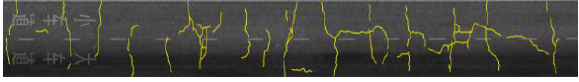
Figure 2. Labeled pavement cracks (yellow).